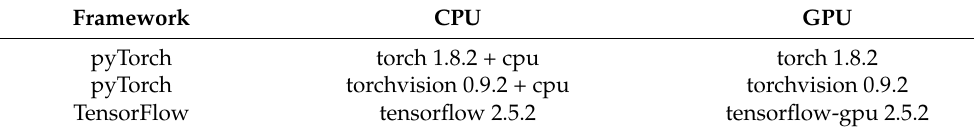
Table A3. The pip3 packages used for the framework